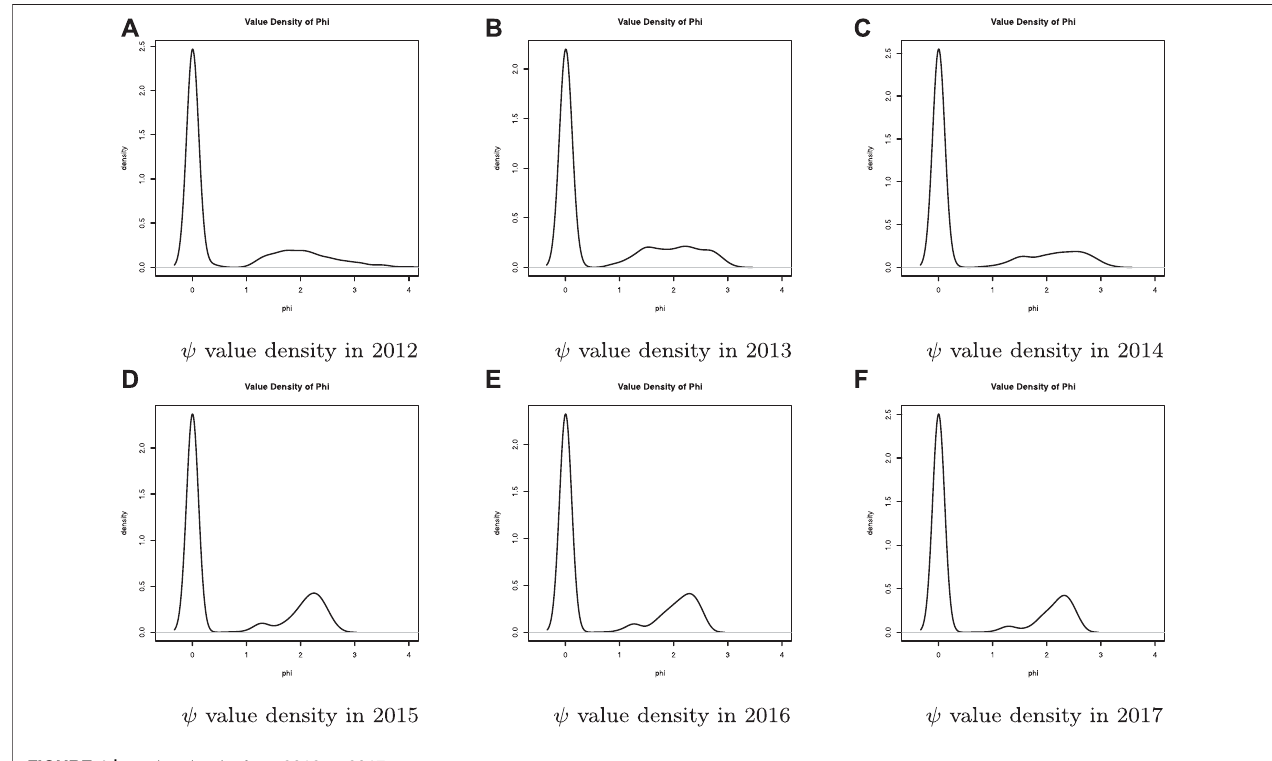
FIGURE 1 | ψ value density from 2012 to